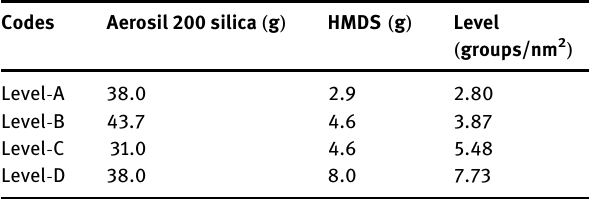
Table 1: Di ff erent levels of treatment of Aerosol 200 and